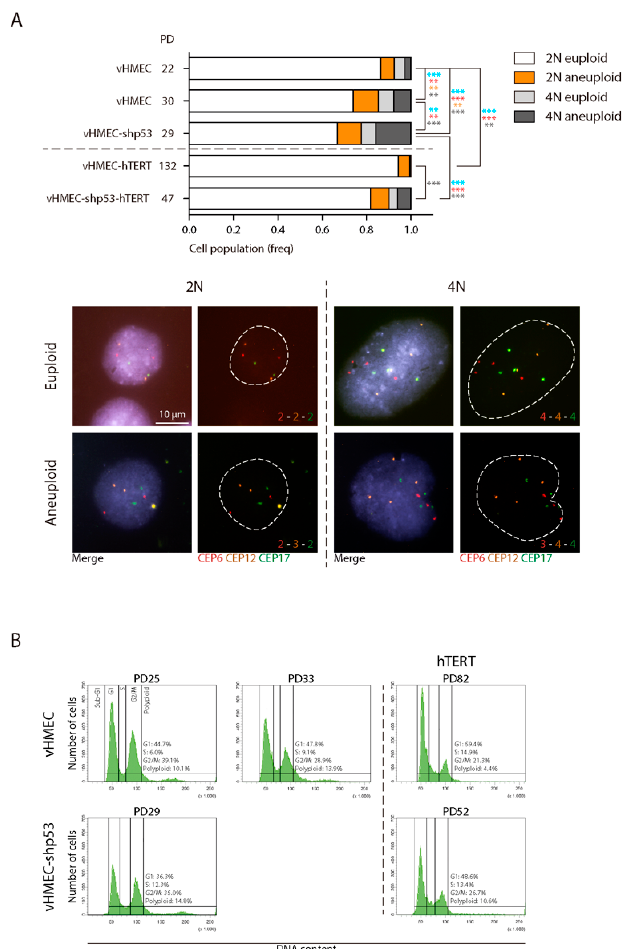
Figure 4. Analysis of chromosome number abnormalities. ( A ) Graph showing the frequency of euploid and aneuploid 2N and 4N among vHMECs after hybridisation with centromeric specific probes for chromosome 6 (CEP6), 12 (CEP12) and 17 (CEP17). Chi 2 test demonstrated a significant increase in cells containing numerical aberrations (blue asterisks). Moreover, tetraploidisation events significantly increased in finite vHMECs with increasing telomere dysfunction and were aggravated when p53 was compromised (Fisher’s exact test, red asterisks). Statistical significance after Fisher’s exact test comparisons regarding 2N aneuploid and 4N aneuploid cells with asterisks in the same colour code as the legend is shown, and only p -values lower than 0.0125 were considered significant. ** indicates p -values lower than 0.01; *** indicates p -values lower than 0.001. Representative images of diploid and tetraploid cells with euploid and aneuploid configurations of tested centromeric probes are depicted. Scale bar corresponds to 10 µm; ( B ) Representative cell cycle profiles of vHMEC cell lines. FACs analysis also demonstrated the increase of polyploid cells concomitant with PDs in finite vHMECs. Immortalisation of young vHMECs did not engender tetraploids, whereas immortalisation of p53-compromised vHMECs resulted in an average 10% proportion of cycling polyploids. Cell cycle phases are marked and values indicated.